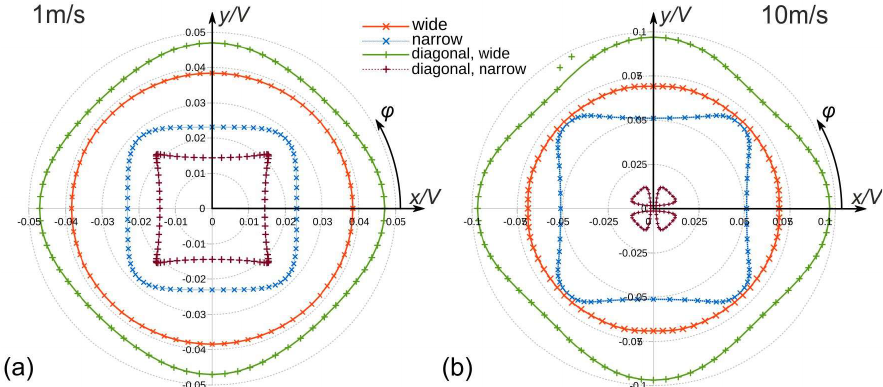
Figure 10. Computed directional diagrams of the bridge detuning signals for the bridge configurations according to Table 2. The marker positions correspond to 5-degree increments of the flow direction ϕ . A bridge supply voltage of 1 V and the values of the simulated thermistor resistances of Figure 8 are presumed. The shown characteristics belong to a mean cross-sectional flow velocity of ( a ) 1 m / s and ( b ) 10 m / s in the channel, respectively.